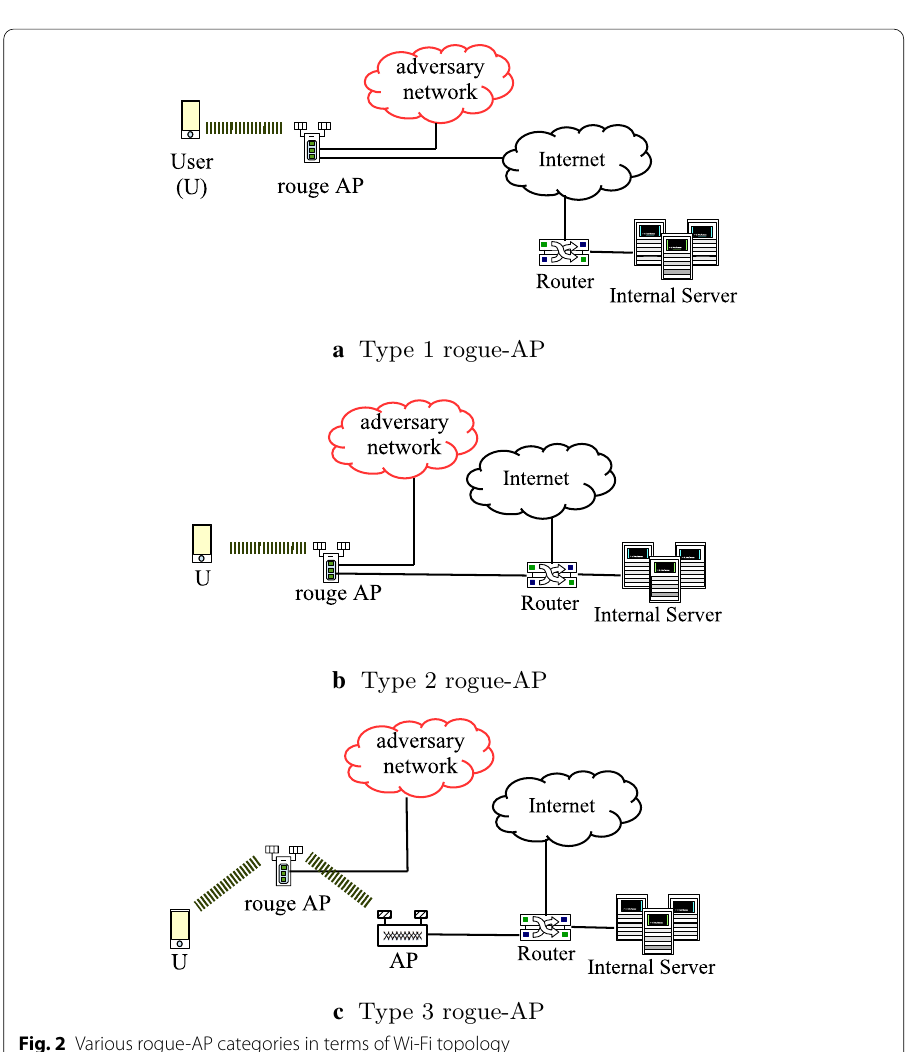
Fig. 2 Various rogue-AP categories in terms of Wi-Fi